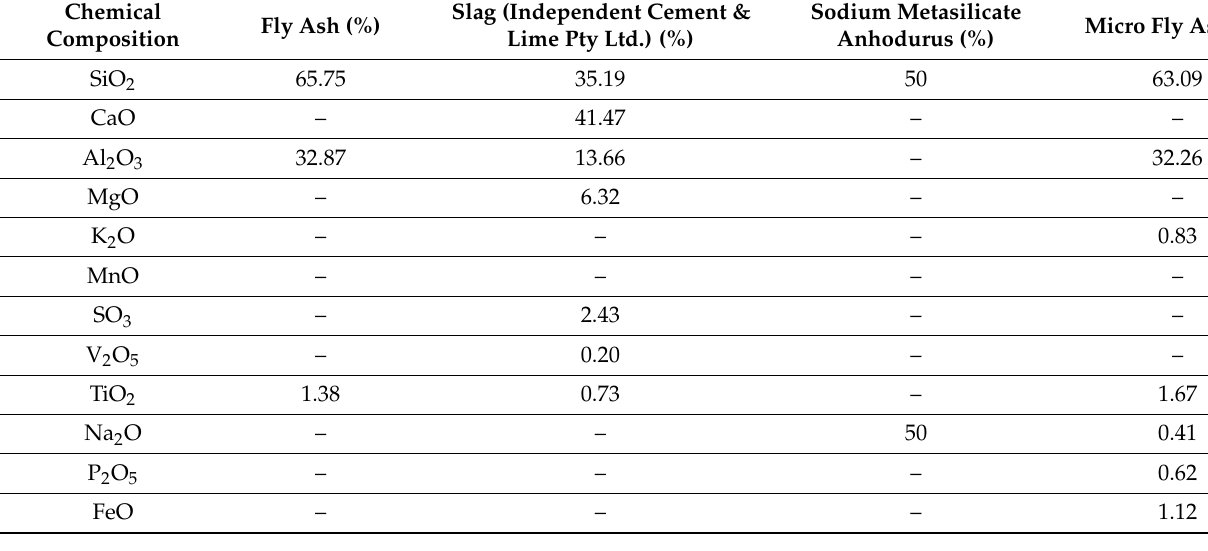
Table 1. Chemical composition details of SCGC mixture.